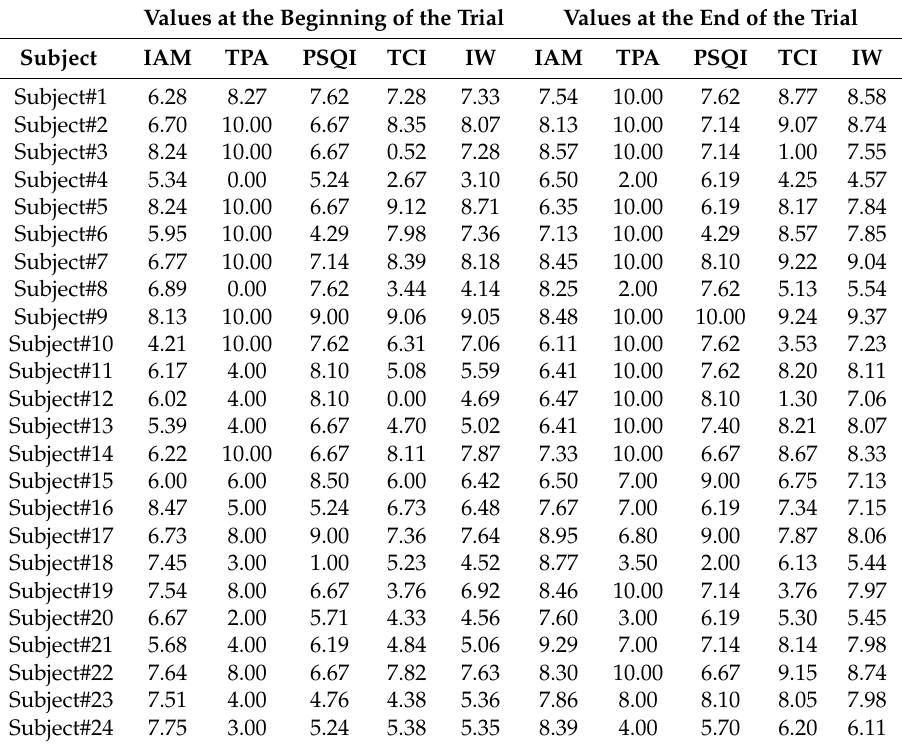
Table 4. Average values of indexes: initial and final values. Values at the Beginning of the Trial Values at the End of the